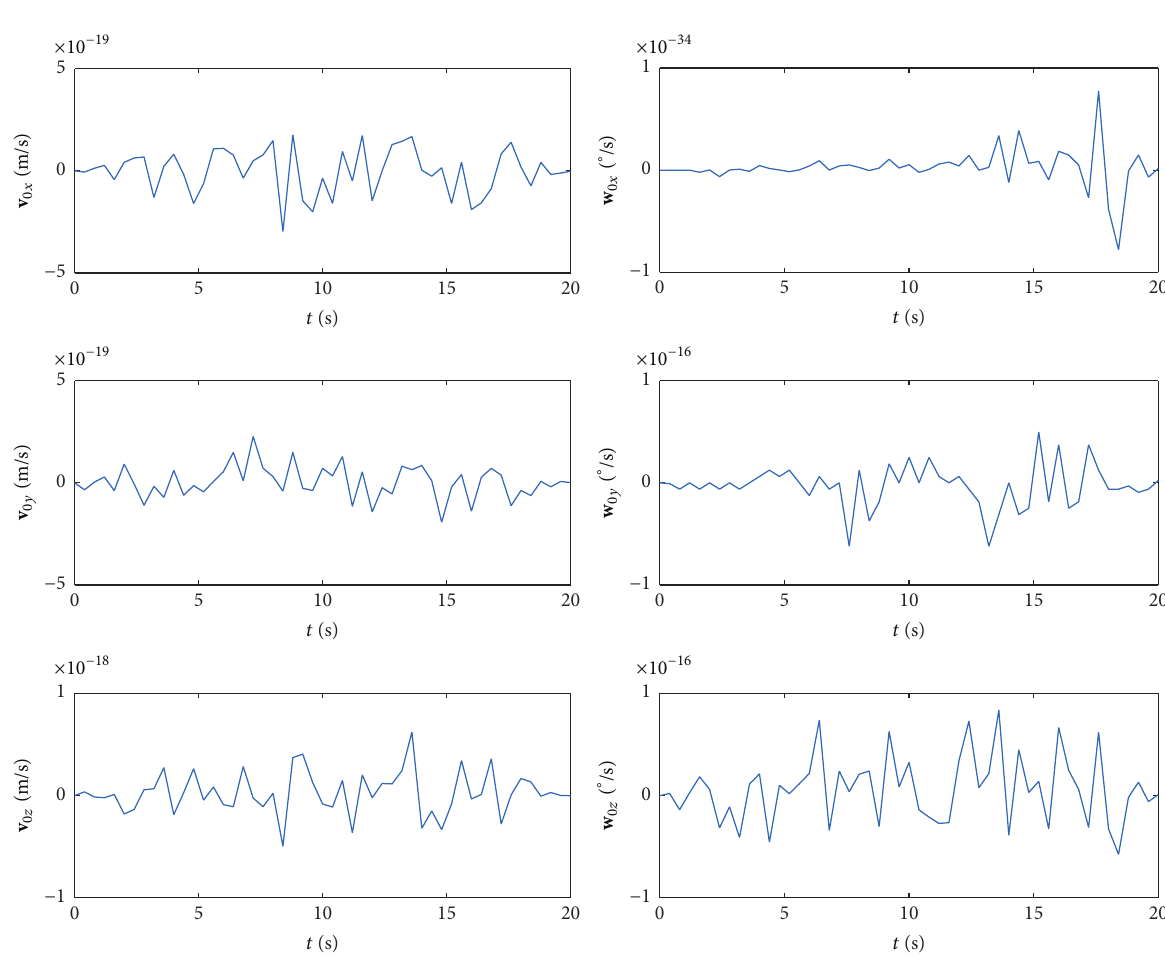
Figure 5: The linear and angular velocities of the